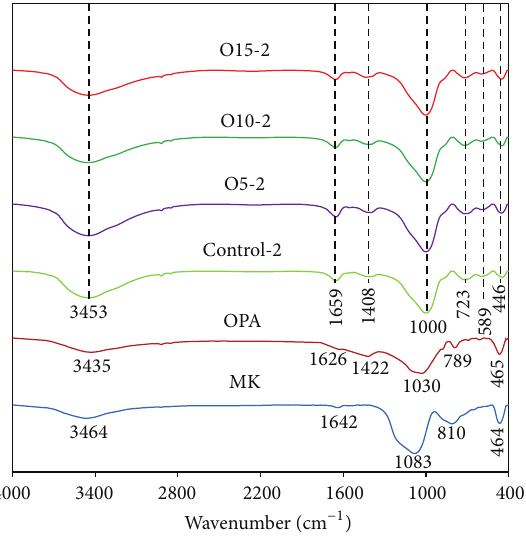
Figure 12: FT-IR spectra of raw materials and the geopolymer samples heat cured for 2 hours.